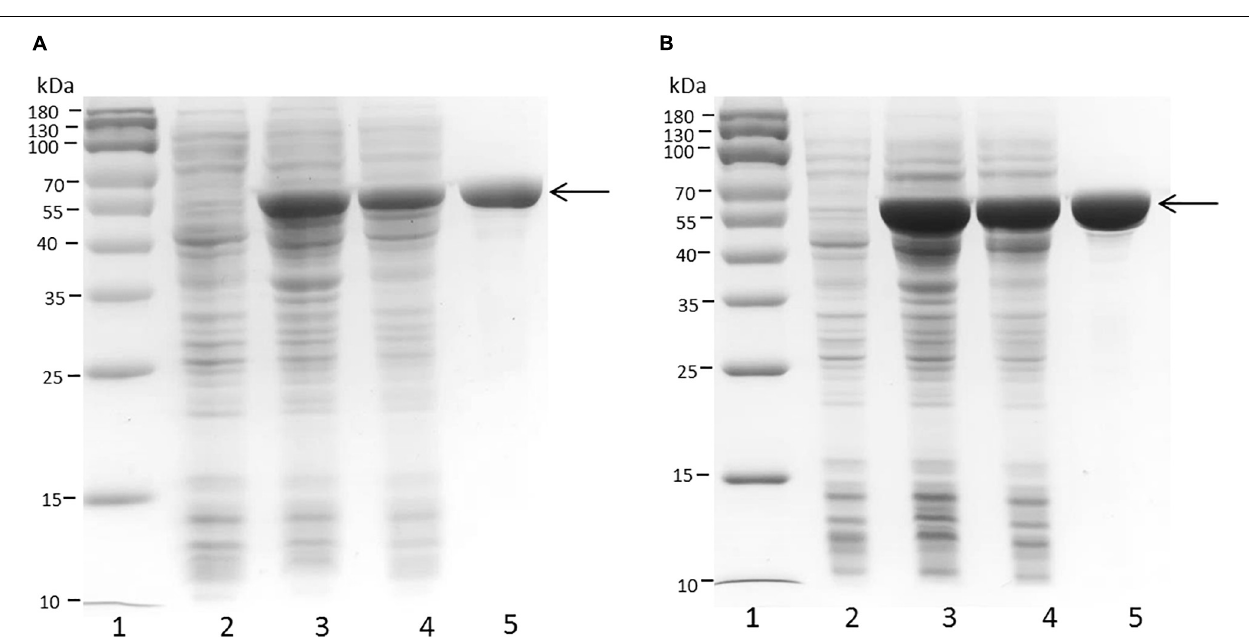
FIGURE 2 | SDS-PAGE of crude and purified recombinant proteins PB_3262 and PB_3285 expressed in E. coli . Expression and purification of recombinant proteins PB_3262 (A) and PB_3285 (B) were analyzed by SDS-PAGE using 13.2% polyacrylamide gels. lane 1, Prestained Protein Marker (MP102) (Vazyme); lane 2, lysate of cells transfected with empty plasmid (pET-30a); lane 3, lysate of IPTG-induced cells transfected with expression plasmid; lane 4, lysate supernatant of induced cells with expression plasmid; lane 5, recombinant PB_3262 or PB_3285 purified with Ni 2 + affinity chromatography. Molecular mass markers and their corresponding masses are also